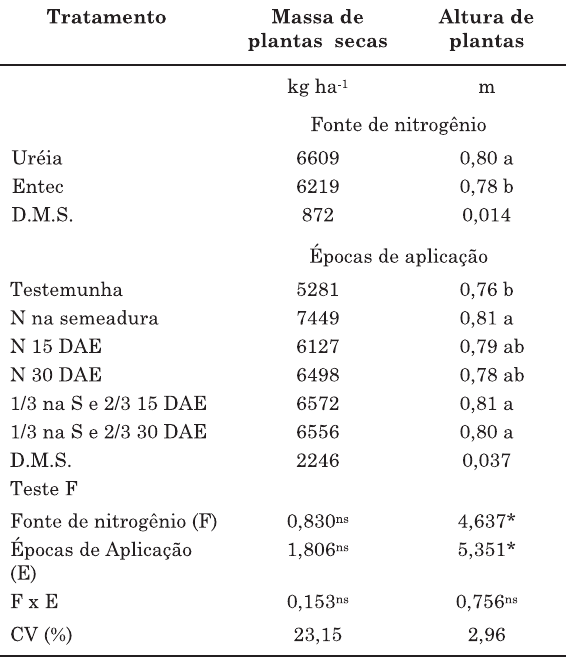
Quadro 3. Componentes vegetativos de grãos de trigo, considerando a fonte e época de aplicação de